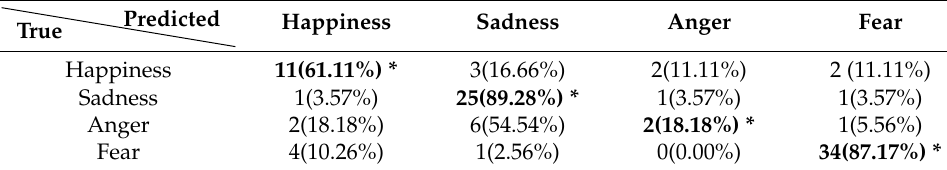
Figure 10. The contribution rates of all 29 features. Table 5. Confusion Matrix on the Test Set.